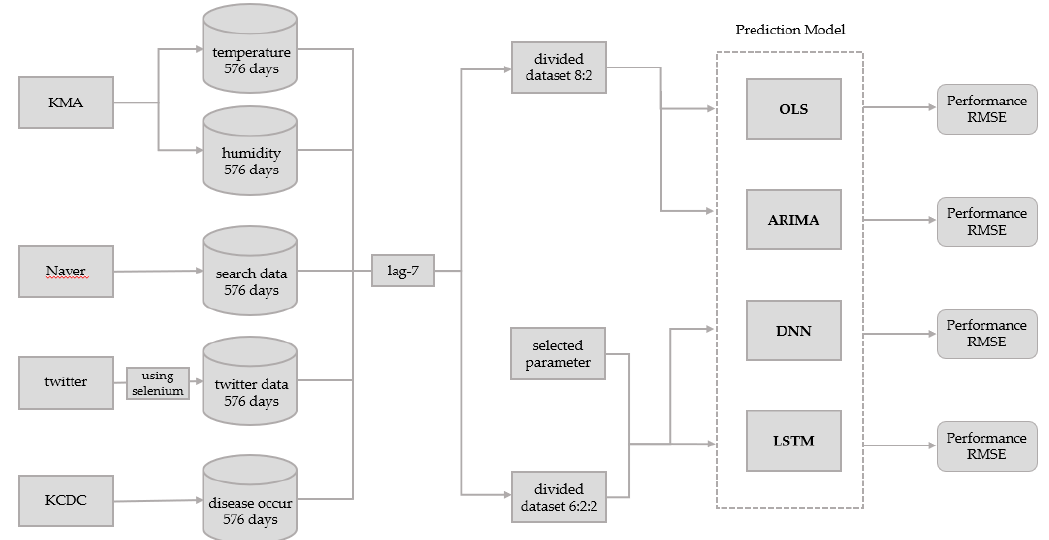
Figure 1. Infectious disease prediction model.